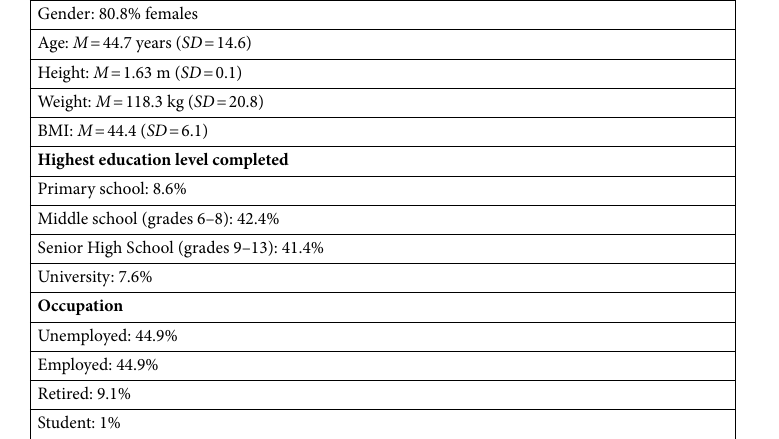
Table 1. Sample characteristics ( n = 198).